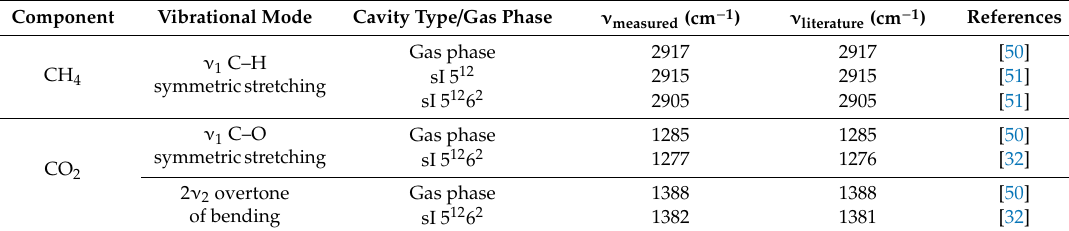
Table 1. Spectroscopic information for the CH 4 and CO 2 molecules in the gas phase and for di ff erent cavities in the hydrate